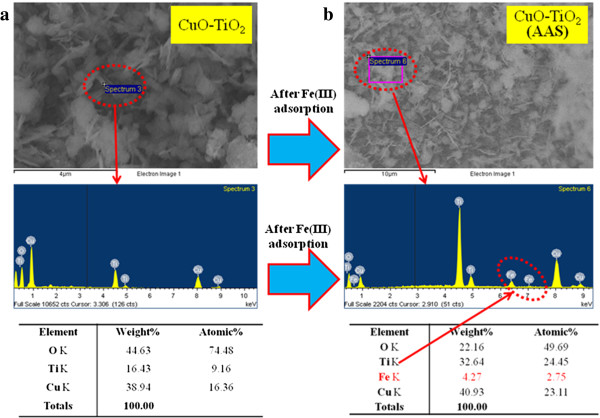
EDS investigation of (a) before and (b) after iron(III) adsorption onto calcined CuO-TiO2 Nanosheets.